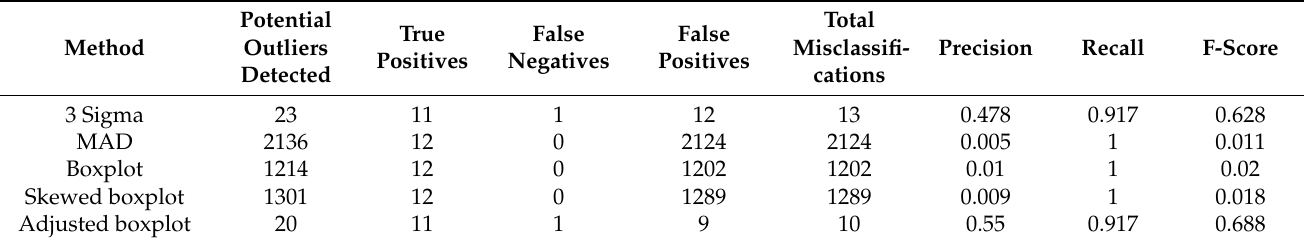
Table 4. Number of outliers found by the Forecast Error method applied to the random forest forecasts on the adapted data.